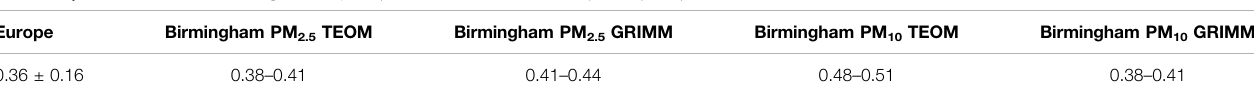
TABLE 3 | κ values drawn from Pringle et al . (2010) — column 1 and from Crilley et al .(2018) — columns 2 –